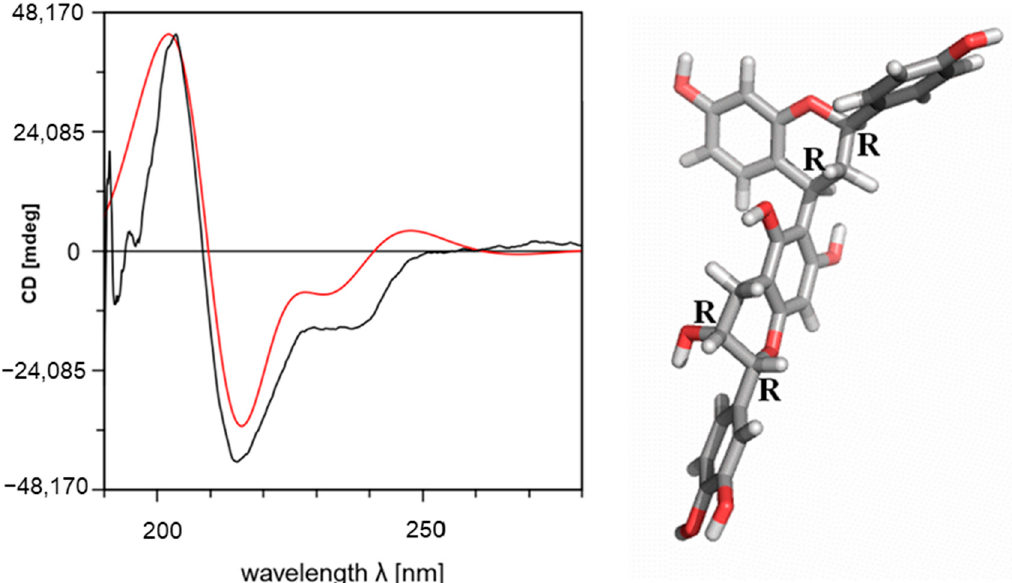
Figure 2. ( left ) Calculated ECD spectrum (red curve) for the P atropisomer with a relative energy of 2.3 kcal/mol of the C4–D6 RRRR isomer (M isomer: see Figure S11) with a similarity of 0.9278 and a shift of 27 nm to the experimental ECD spectrum (black curve); ( right ) related structure with the dihedral angle (A10–C4–D6–D5) = − 61.4°.